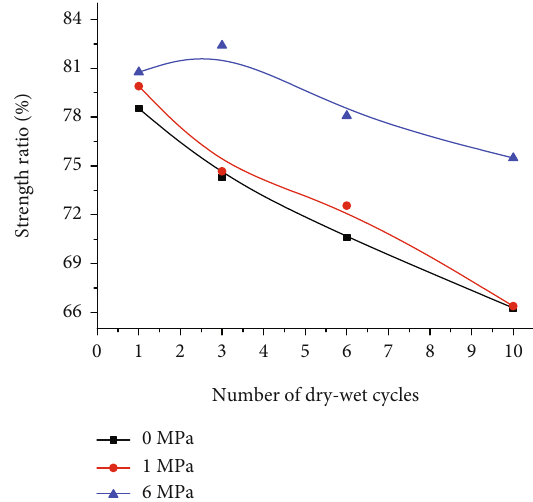
Figure 12: Strength ratio of saturated rock samples to dry rock samples after the same number of dry-wet cycles (after [54]).